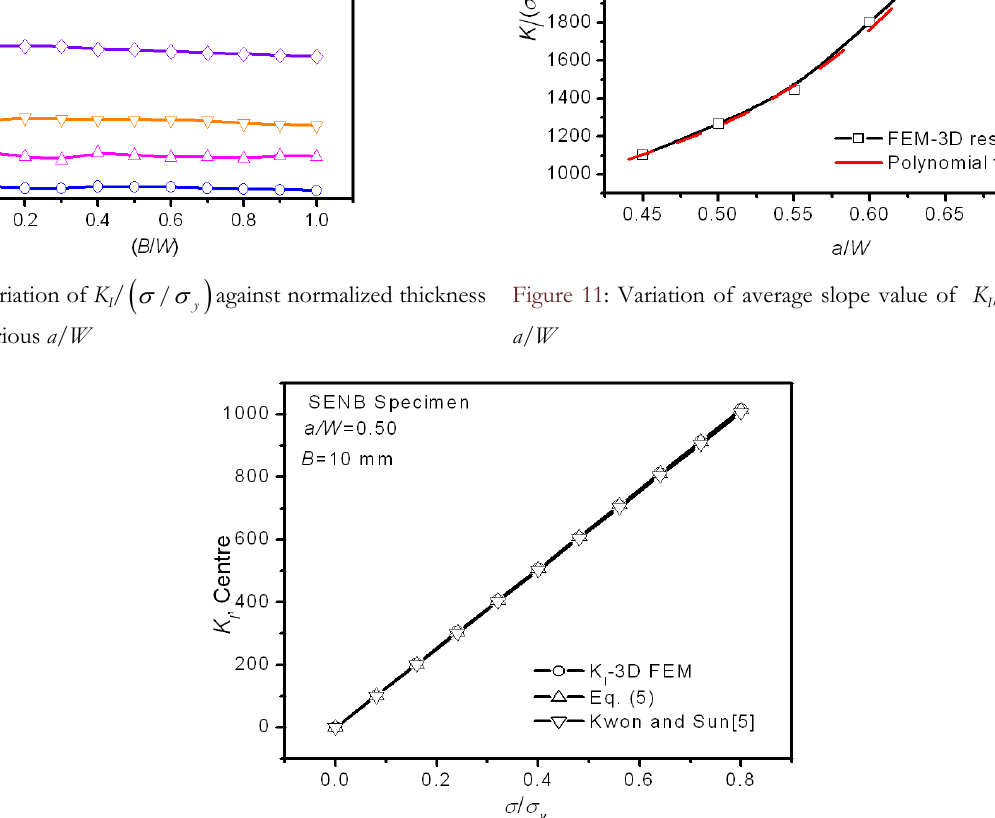
Figure 12: Comparison of K estimated using Eq.(5) for typically, a/W =0.50 and B =10mm is with present 3D FE results and results of I Kwon and Sun